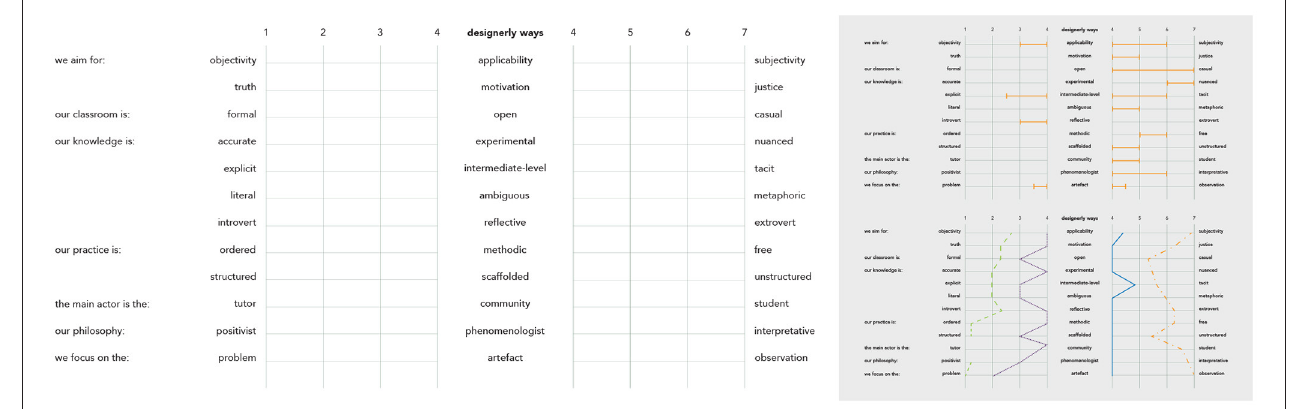
FIGURE 9 | To the left, the community-based designerly scale applied to HCI, where the differentials describe extremes representing different disciplines, with design discipline poised in the middle. This scale can be used both when designing courses, but also as a support for discussions between instructors and students on what type of knowledge and posture should or will be adopted in a course. To the right, an example of two possible ways to fill in the